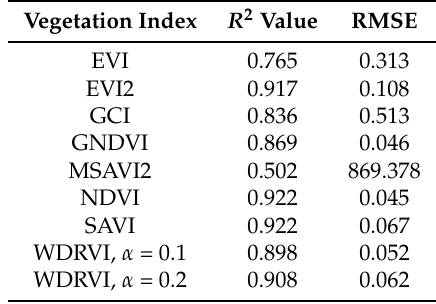
Table 3. Candidate vegetation indices, the R 2 value of their fit to the asymmetric double sigmoid function, averaged across all plots, and the root mean square error (RMSE) value of their fit to the asymmetric double sigmoid function, averaged across all plots. Unlike most of the indices, Green Chlorophyll Index (GCI) and Modified Soil-Adjusted Vegetation Index 2 (MSAVI2) are not scaled between − 1 and 1, so their RMSE values cannot be directly compared with those of the other indices. Vegetation Index R 2 Value RMSE EVI 0.765 0.313